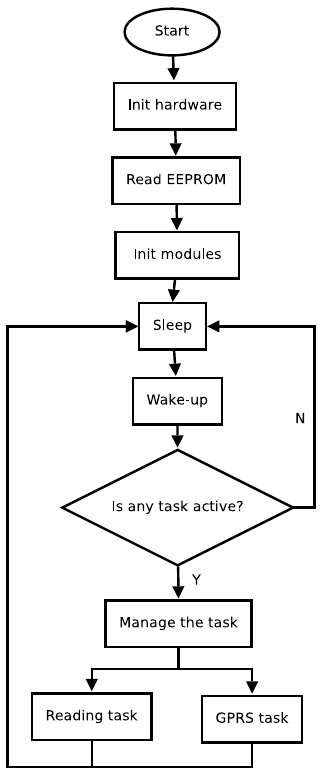
Figure 8. Flowchart showing the main loop routine of node